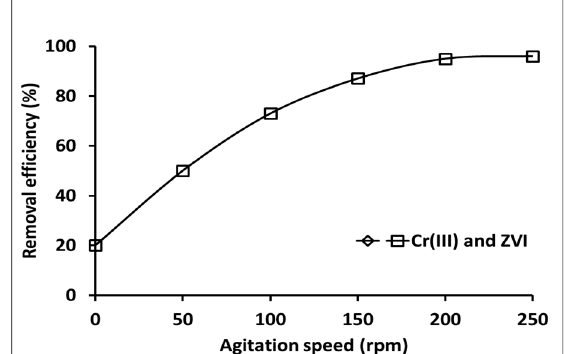
Fig. 5. Effect of agitation speed on the removal efficiency of chromium ions onto ZVI at pH 5.5, 50 mg/L initial contaminant concentration, and 250 min contact time.